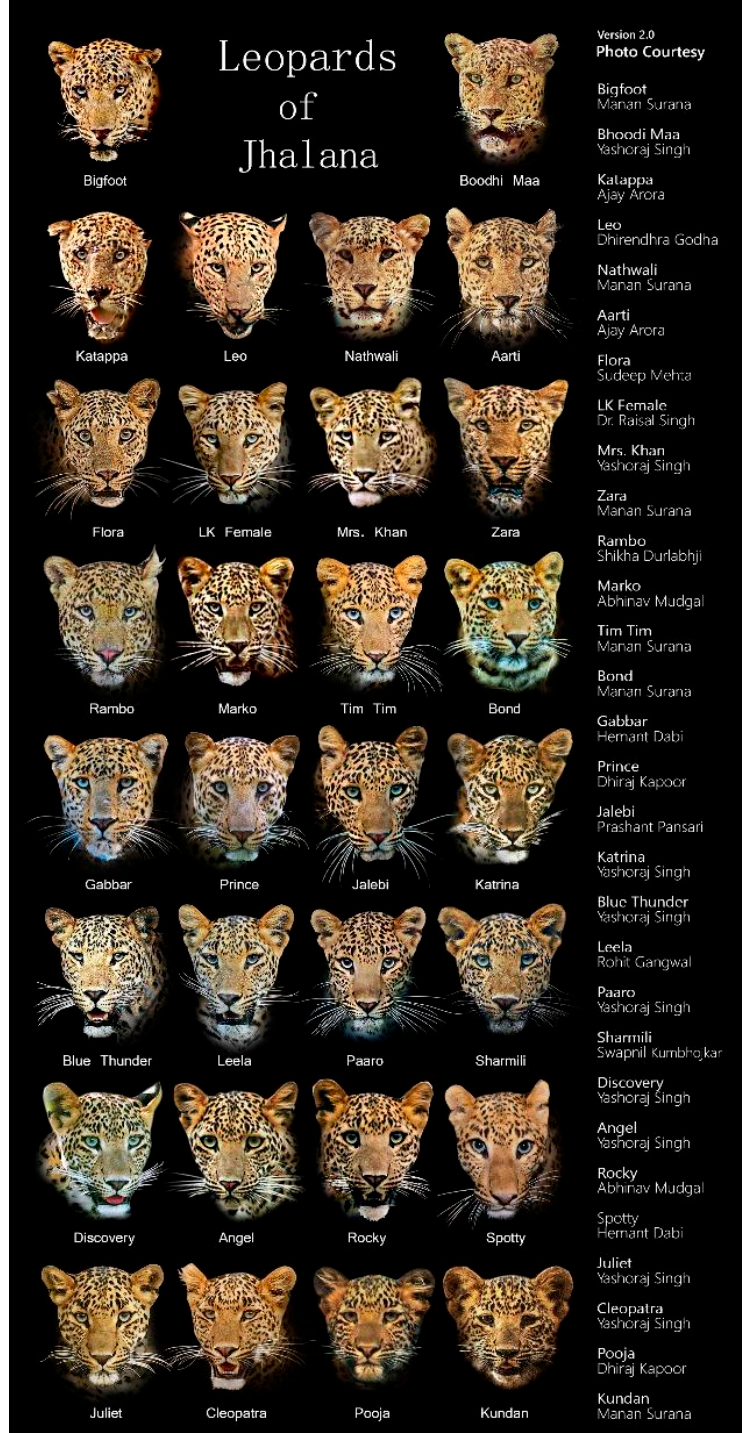
Figure 2. Facial portraits of the Leopards of Jhalana Forest Reserve during 2019. Text on the right indicates photo credits.